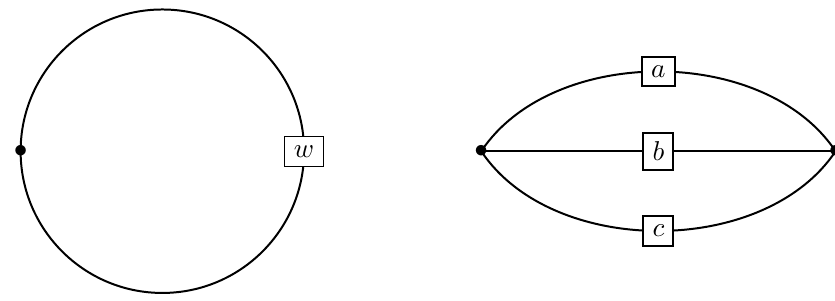
Figure 1 . The graphs corresponding to the one-loop and two-loop modular graph functions E w and C where a link with a boxed number w indicates w concatenated Green a,b,c